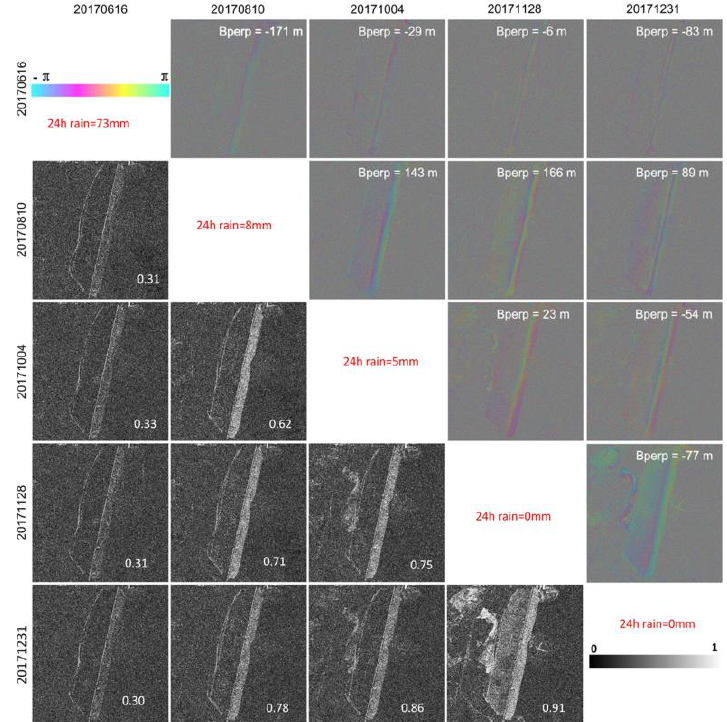
Figure 11. The differential interferograms and coherence map of the descending TSX-SL images.